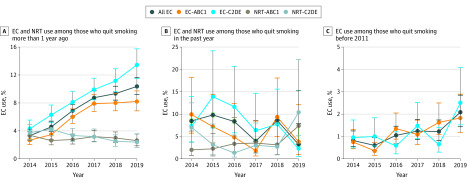
Trends in e-Cigarette (EC) and Nicotine Replacement Therapy (NRT) Use Among Individuals Who Quit Smoking in England, 2014-2019ABC1 indicates higher and intermediate managerial, administrative and professional, supervisory occupations, and clerical and junior managerial occupations; and C2DE, semiskilled and unskilled manual workers, state pensioners, casual and lowest-grade workers, and unemployed with state benefits only. Whiskers indicate 95% CIs.